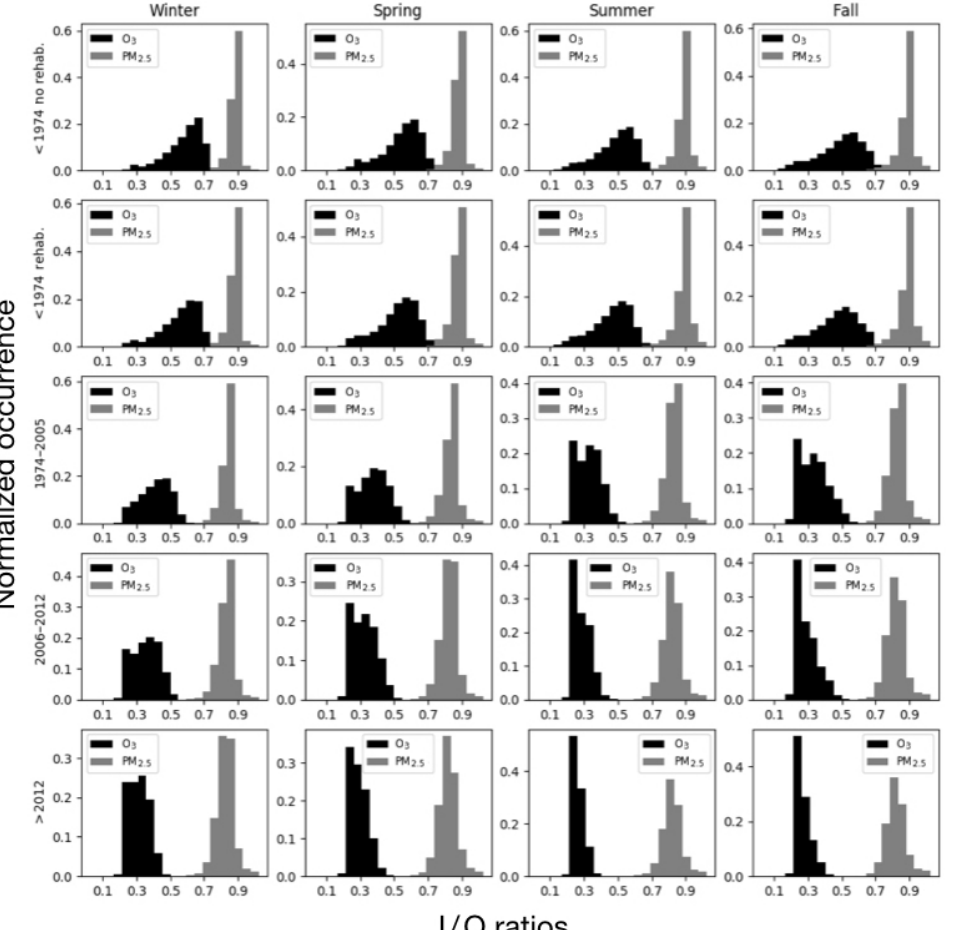
Figure 4. O 3 and PM 2 . 5 indoor / outdoor ratios modelled with the SIREN model for dwellings (unitless). The number of occurrences of the histogram is normalized over the size of the dataset.